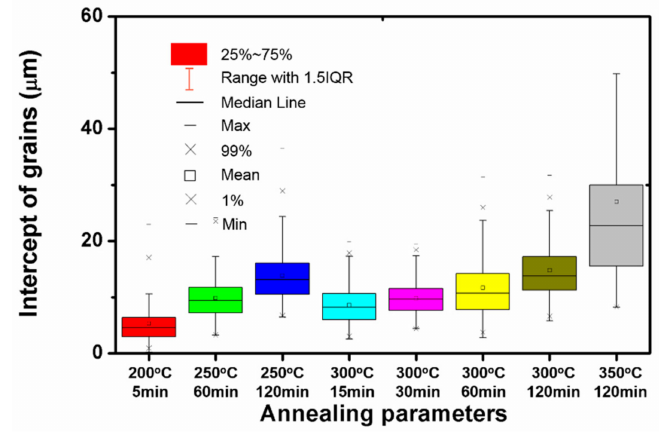
Figure 9. The grain intercepts distribution of the as-annealed Mg wires. Table 1. The statistic results of the as-annealed pure Mg wires at di ff erent recrystallization